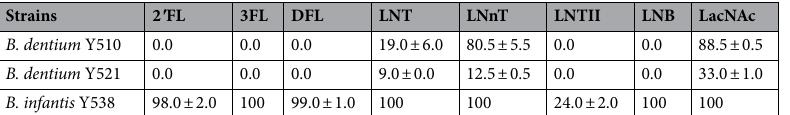
Table 2. Percentage of oligosaccharide utilized by the Bifidobacterium strains in the fermentation conditions described in “Methods”. 2 ′ FL 2 ′ -Fucosyllactose, 3FL 3-fucosyllactose, DFL difucosyllactose, LNT lacto- N - tetraose, LNnT lacto- N -neotetraose, LNTII lacto- N -triose, LNB lacto- N -biose, LacNAc N -acetyllactosamine.